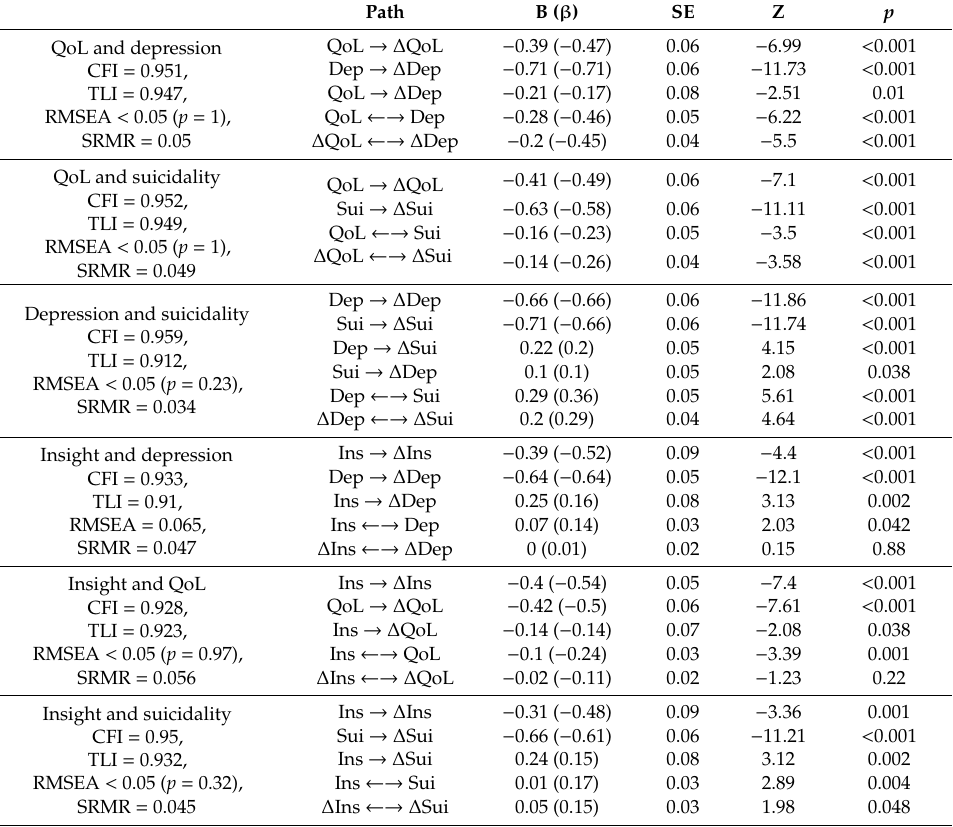
Table 2. Unstandardized (B) and standardized ( β ) coupling and autoregressive path ( → ) and